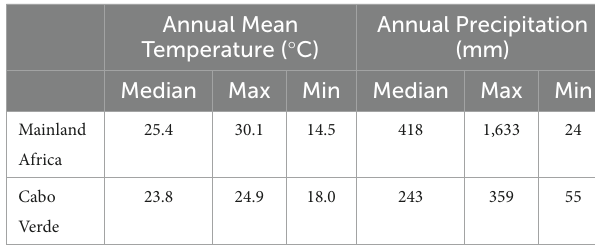
TABLE 3 Annual mean temperature and precipitation for the current habitat conditions of Faidherbia albida in mainland Africa and Cabo